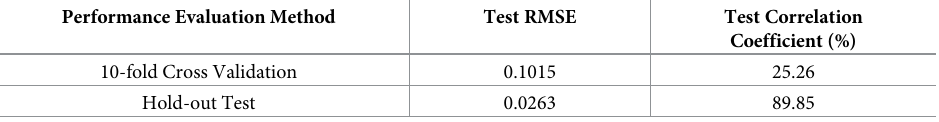
Table 3. Yield prediction performance of the proposed model without including inbred ID and tester ID in the